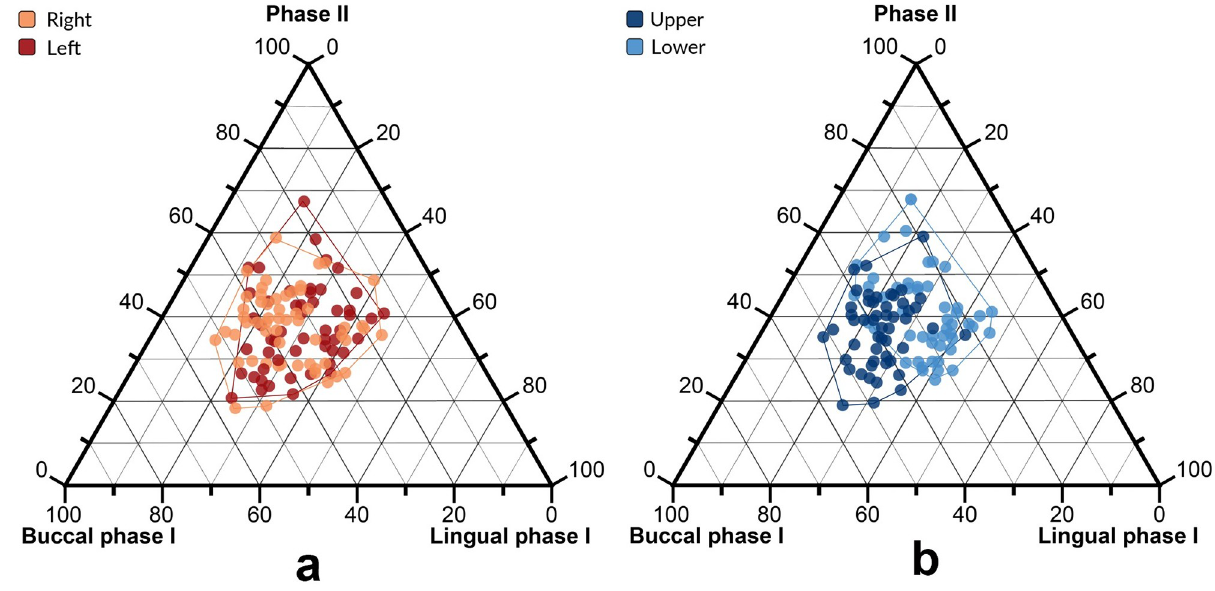
Fig 4. Ternary diagrams showing the proportions (in %) of relative wear areas comparing left and right ( a ), and upper and lower teeth ( b ). The three variables (Buccal phase I, Lingual phase I and Phase II areas) are positioned in an equilateral triangle. Each base of the triangle represents a ratio of 0% while the vertices correspond to a percentage of